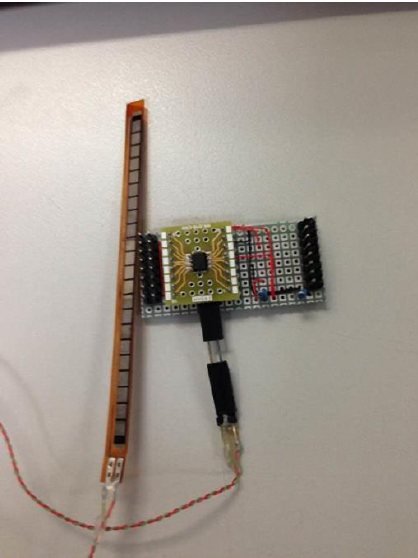
Figure 10. Implementation of respiratory sensor.